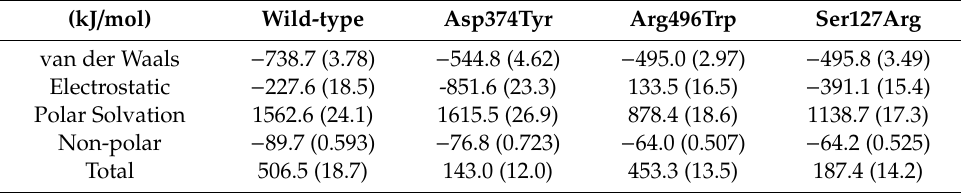
Table 1. Decomposition of the MM / PBSA energies by interaction type (uncertainty in parentheses).